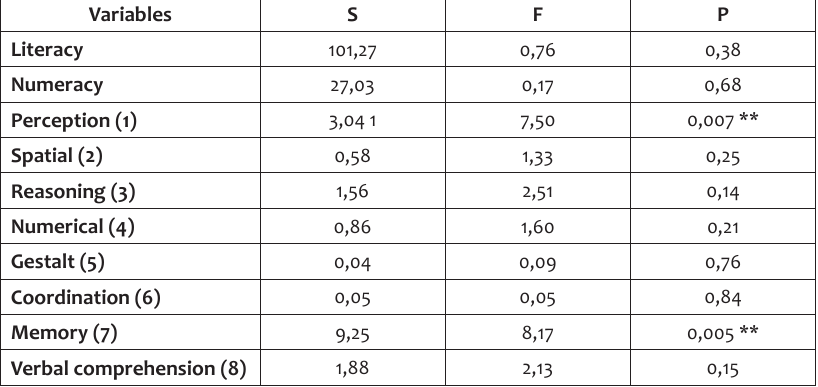
Table 1: Differences in school readiness of six- and seven-year-old learners (N = 137) Variables S F P Literacy 101,27